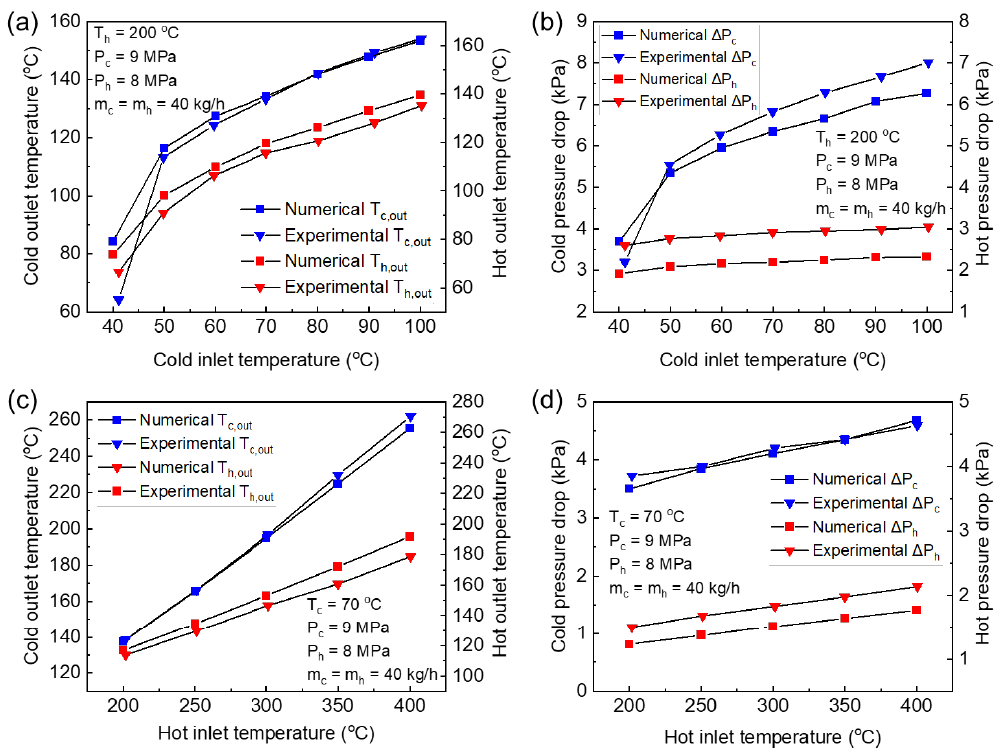
Figure 10. Comparison of simulation and experimental results of ( a , c ) outlet temperature and ( b , d ) pressure drop on both sides.